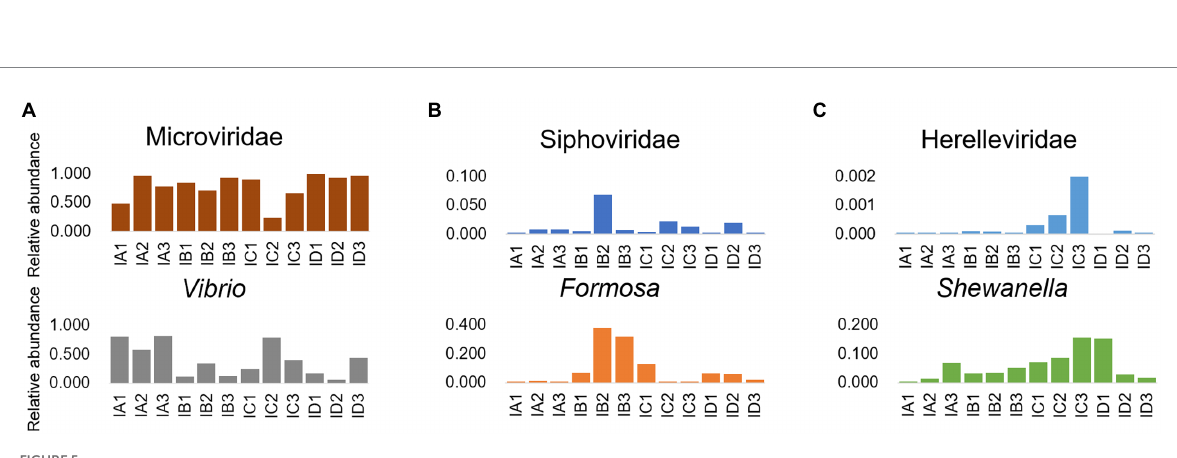
FIGURE 5 Interactional analysis of the phage and prokaryote in shrimp intestine and sediment. Relative abundance of phage (family level) and prokaryote (genus level) pairs with significant correlation ( p < 0.05), which were dominated in the shrimp intestine microbial community, including (A) Microviridae and Vibrio; (B) Siphoviridae and Formosa; and (C) Herelleviridae and